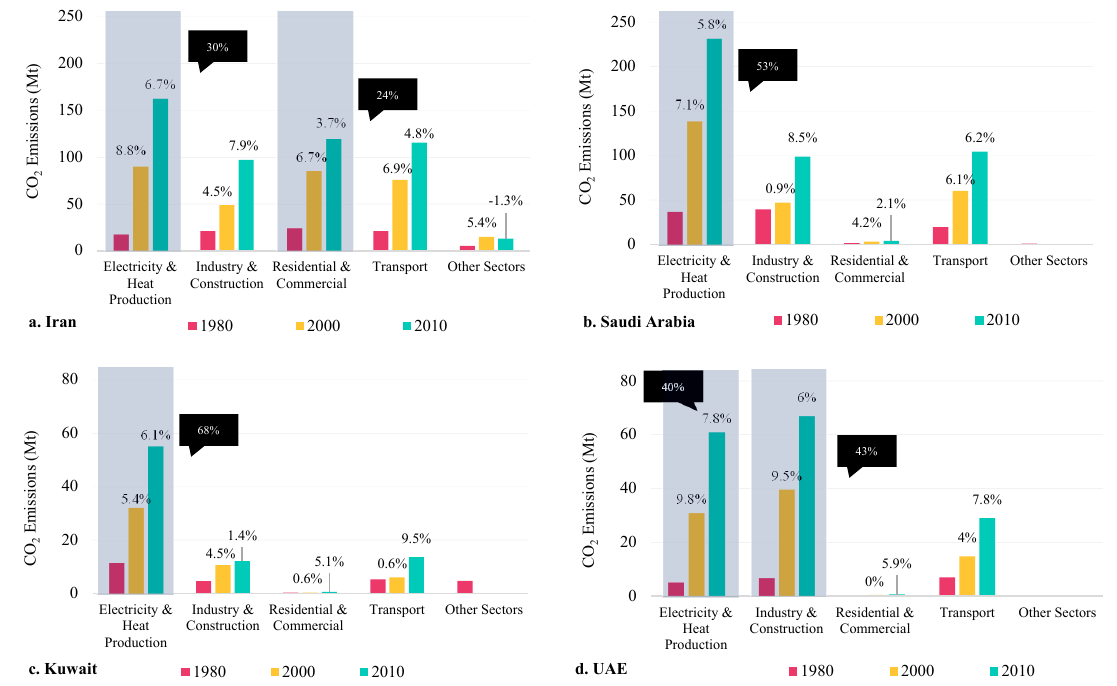
Figure 7. CO 2 emissions by sector across the four major emitters, the percentage refers to the annual growth rate from the previous year. Highlighted sectors accounted for more than 50% of total CO 2 emissions in 2010. Emissions from the building sector (commercial and residential) refer to emissions from onsite power generation and burning fuels for heat. In addition, emissions from electricity use are excluded from the building sector and covered in electricity and heat production. Other sectors refer to emissions from the energy sector that are not associated with electricity and heat production. Based on data from